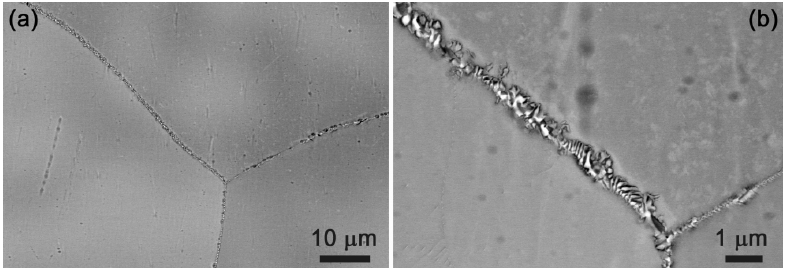
Figure 11. SEM micrograph (secondary electrons) of HfNbTaTiZr alloy annealed at 1000 °C for 1 h and slowly cooled with furnace ( a ) boundary between three grains, ( b ) detail of particles of the Hf, Ti, Zr-rich hcp phase formed preferentially at grain boundaries.